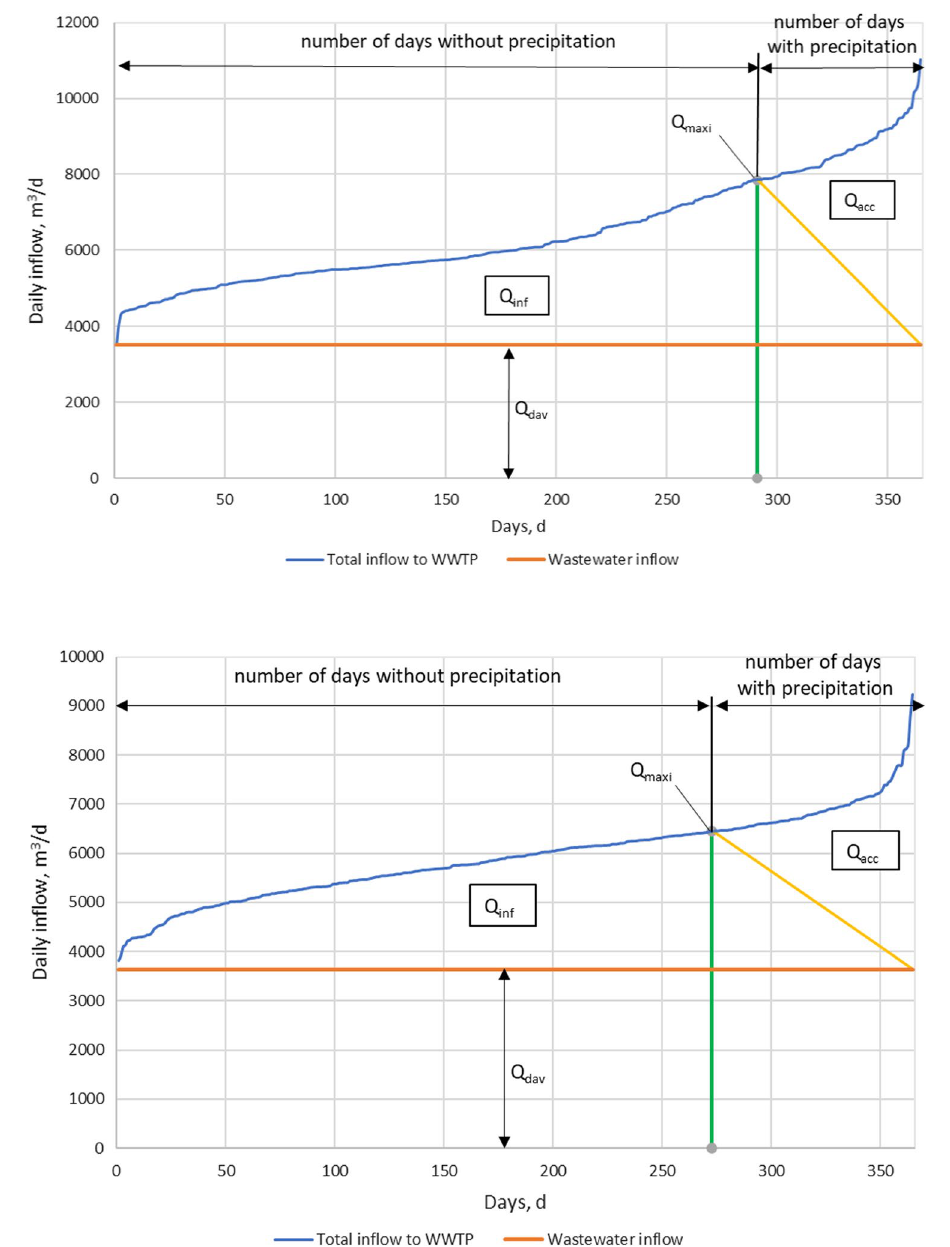
Fig. 6 Volumes of infiltration and accidental water inflow to WWTP in 2018 determined using the triangle method